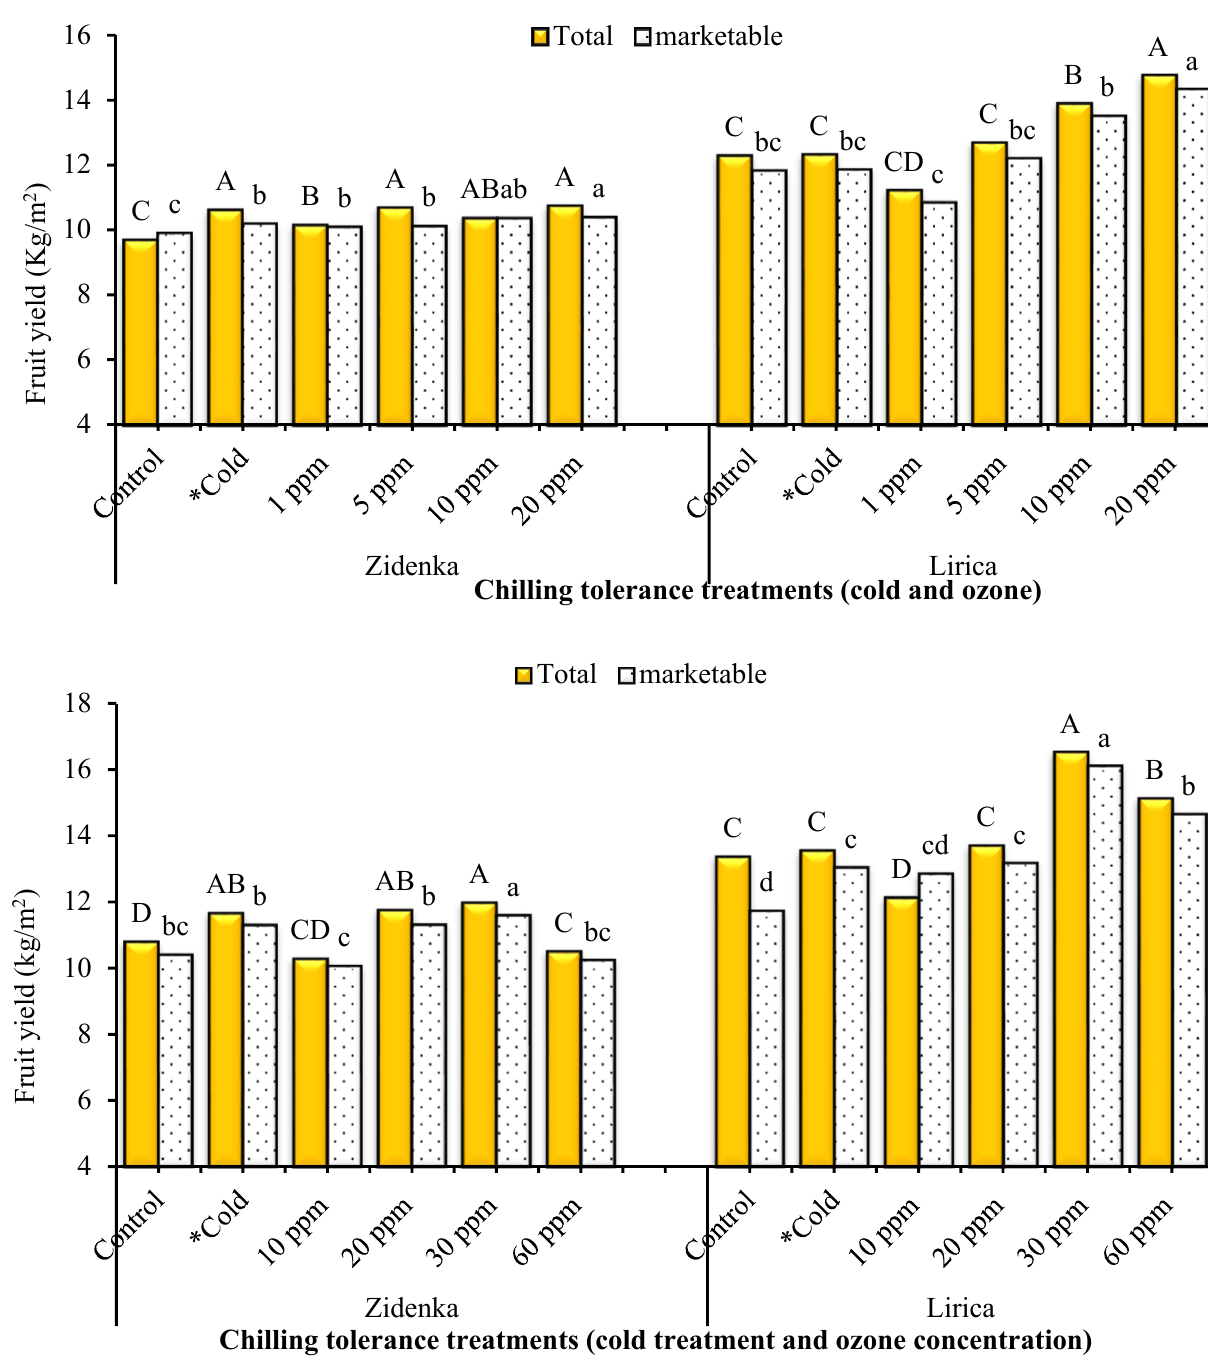
Figure 7. Effect of seedlings spray with different ozonated water concentrations and cold pre- treatments on total and marketable fruit yields of two sweet pepper hybrids during the 2017/2018 (upper figure) and 2018/2019 (lower figure) seasons. The columns labeled with different letters in the same case are significantly different according to Duncan’s multiple range test at 0.05 levels. * Cold treatment was performed at 4 °C for 36 h.